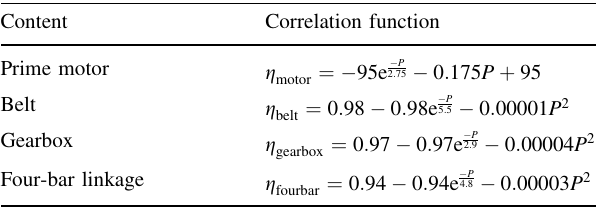
Table 3 Correlation function of transmission efficiency Content Correlation